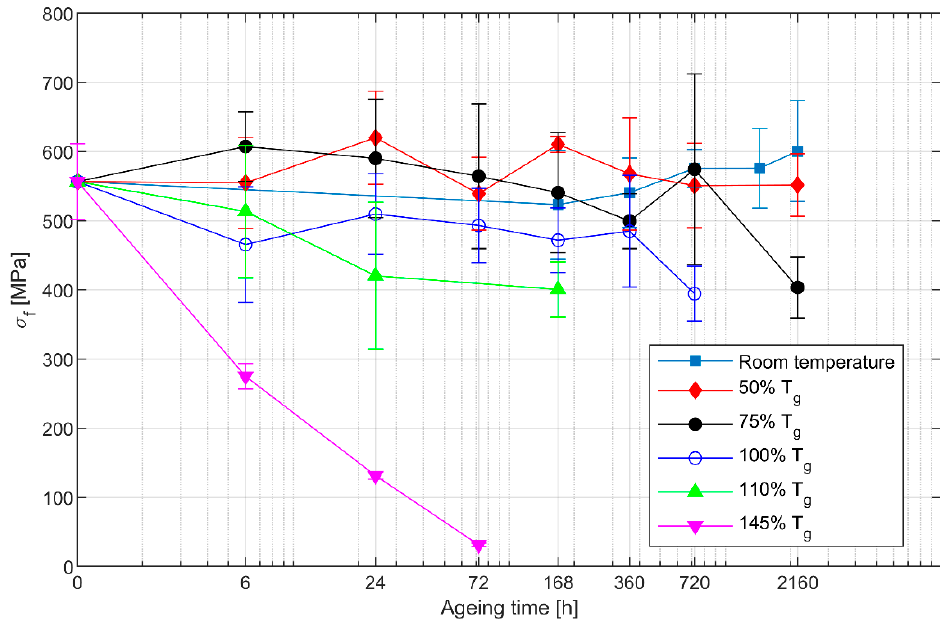
Figure 2. Flexural strength of the isothermally aged specimens. The logarithmic scale on the horizontal axis has been adjusted so that the leftmost point represents the specimens in the unaged condition.